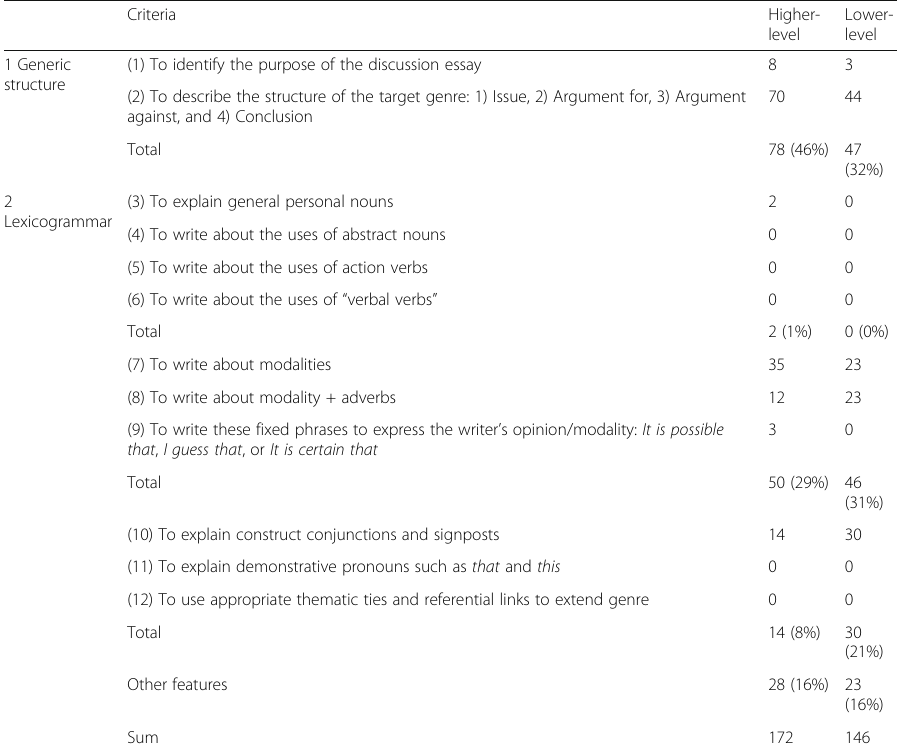
Lower- level level